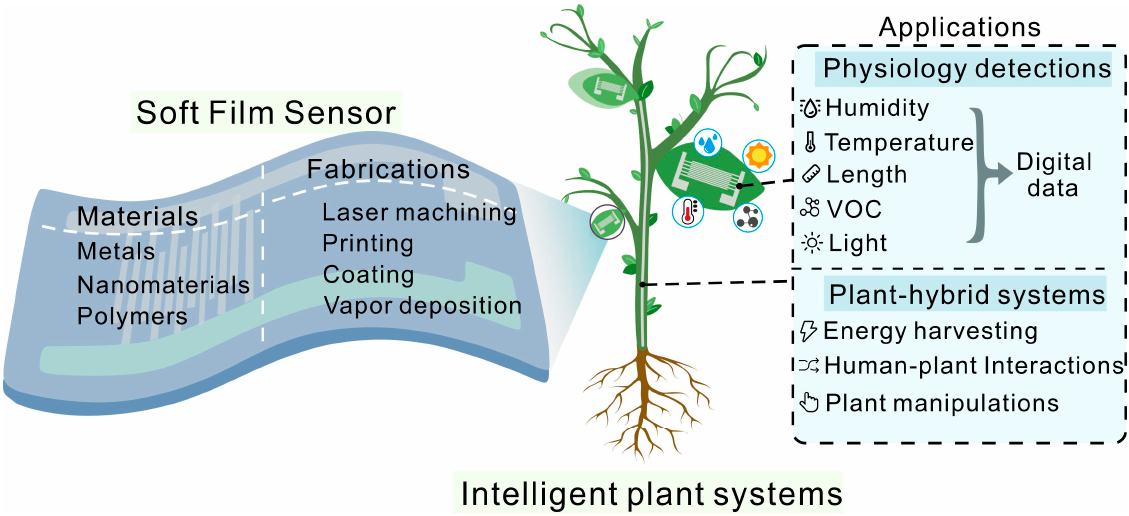
Figure 1. Overview of micro/nano soft fi lm sensors for the establishment of intelligent plant systems.